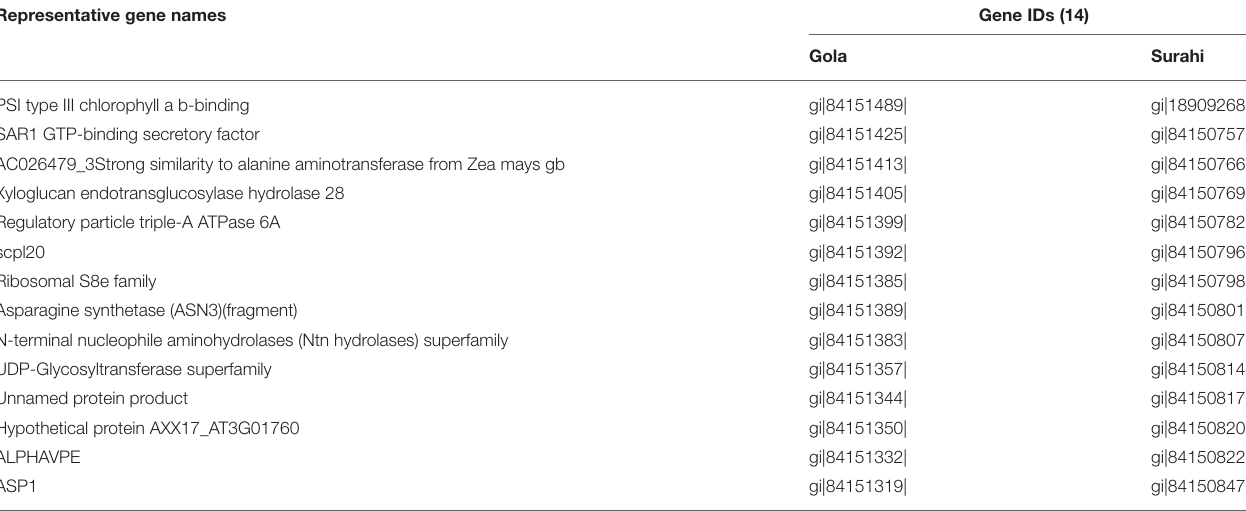
TABLE 7 | Number of similar ESTs upregulated in “Gola” and “Surahi” cultivars under drought